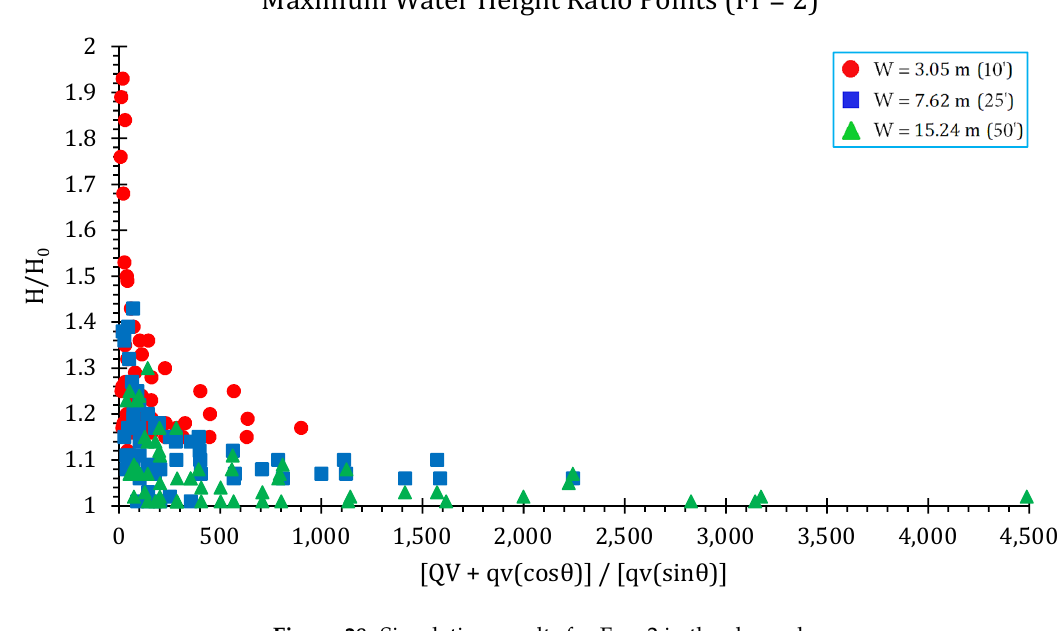
Figure 28. Simulation results for Fr = 2 in the channel.